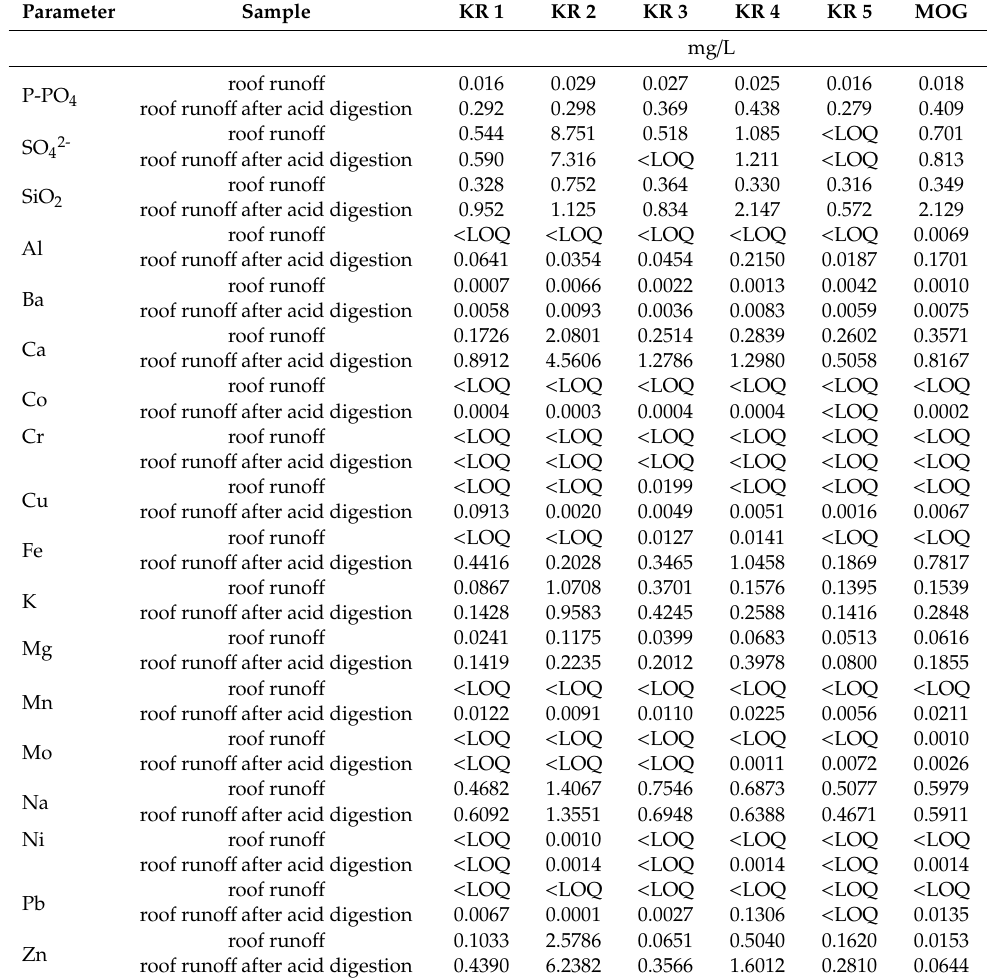
Table 3. Contents of the investigated elements identified in the roof runo ff samples, without and after acid digestion, from research conducted in the winter of